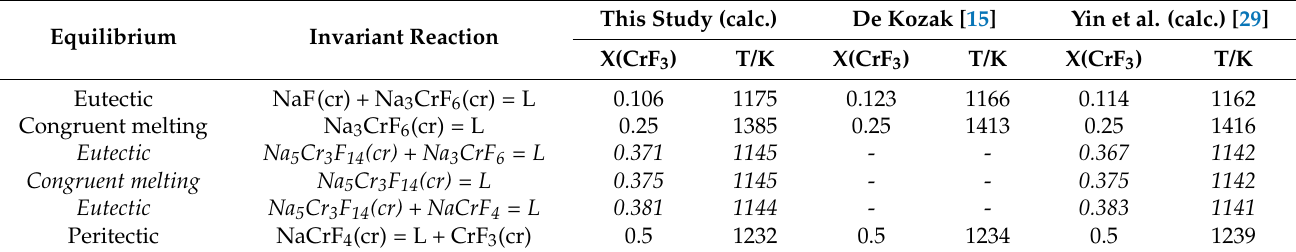
Table 6. Invariant equilibria in the NaF–CrF 3 system.